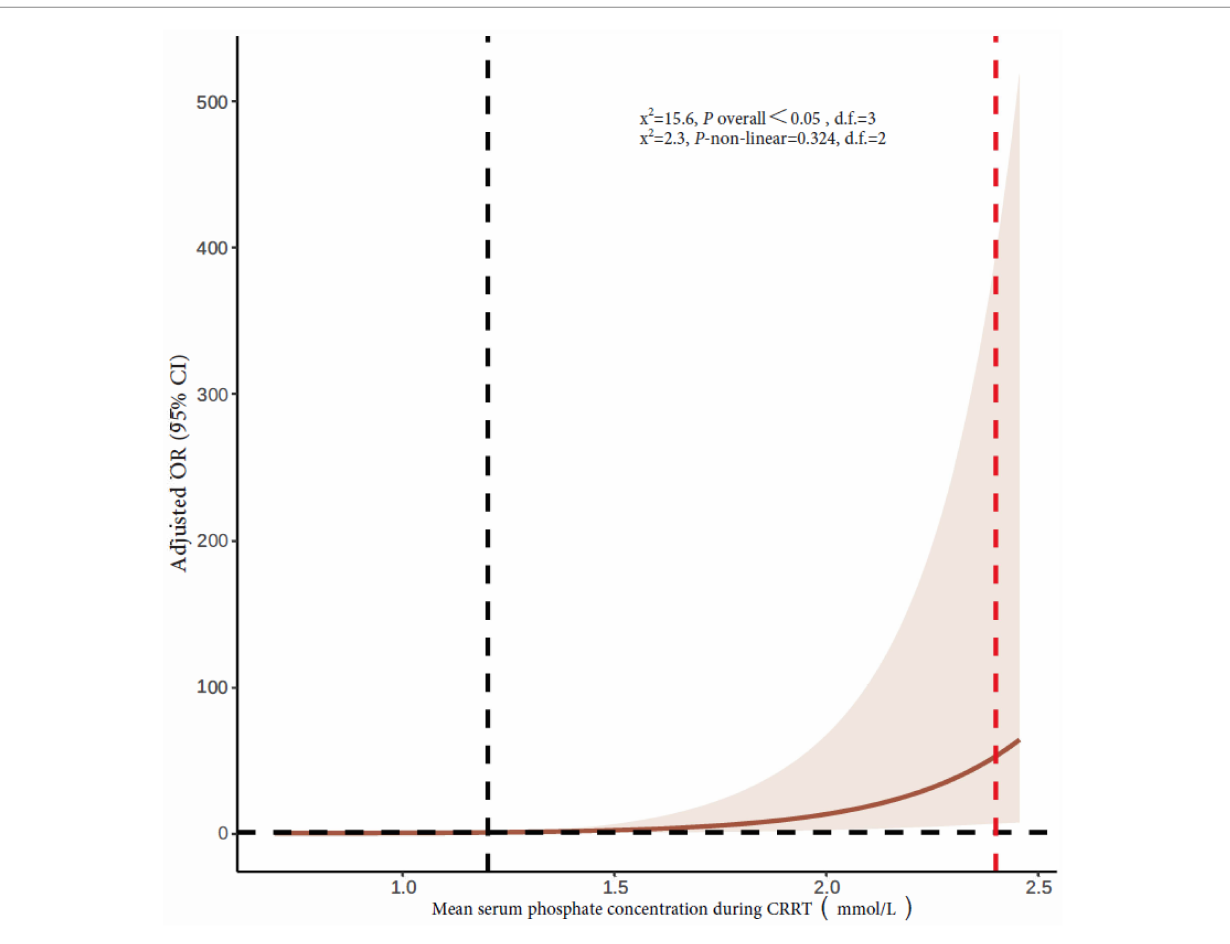
FIGURE 3 Restricted cubic splines of the association between mean serum phosphate concentration during CRRT and 90-day mortality rate. The vertical dotted red line indicates hyperphosphatemia cutoff, and the dotted black line indicates an OR of 1. CRRT, continuous renal replacement therapy; OR, odds ratio; CI, con fi dence